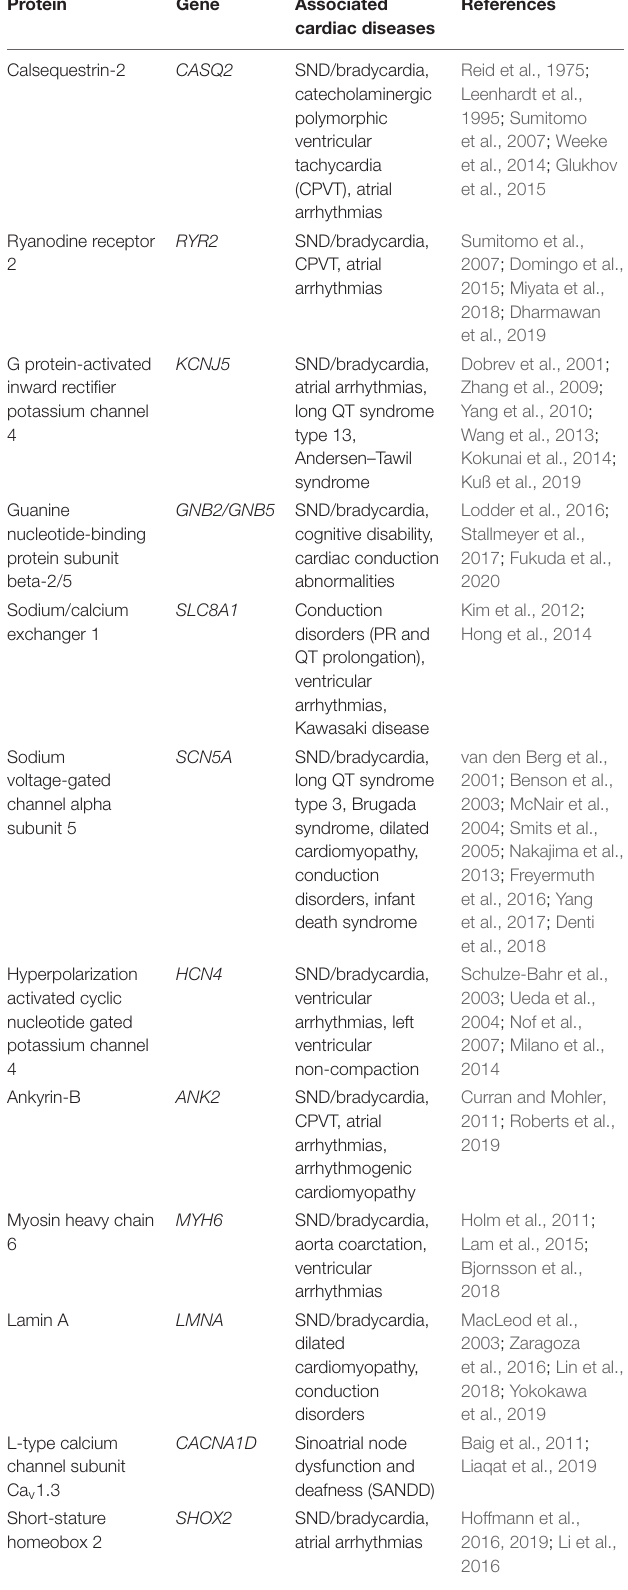
TABLE 1 | Proteins implicated in human